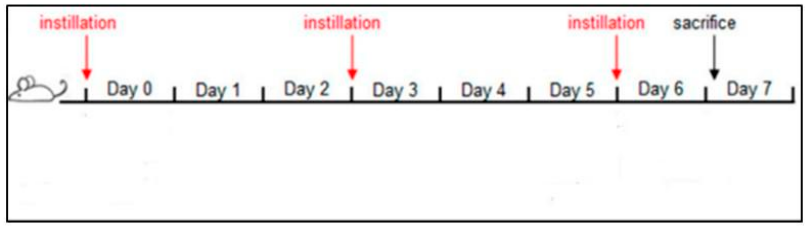
Figure 1. Schematic representation of the subacute treatment of BALB/c mice with PM2.5